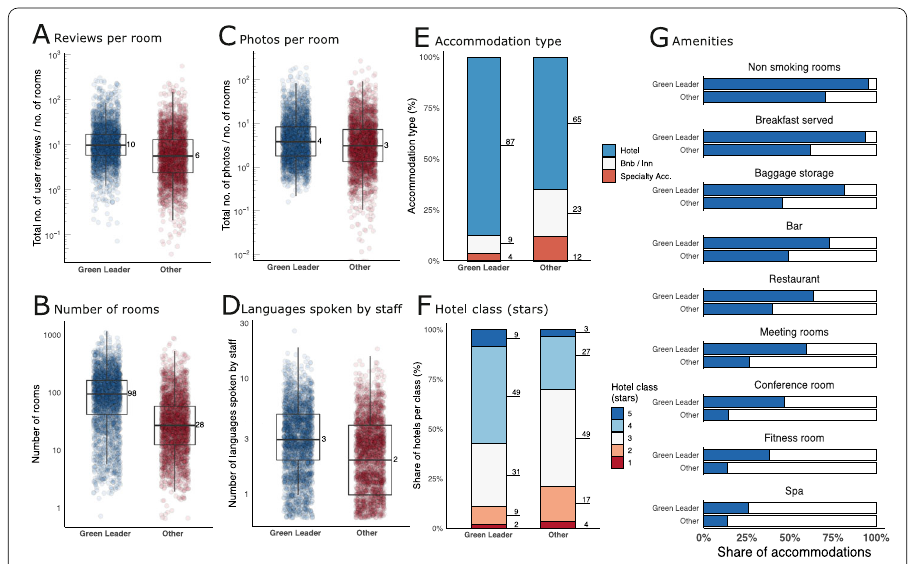
and languages spoken by staff in GreenLeader (blue) and other (red) accommodations. ( E )–( F ) Proportion of accommodation types and hotel class (stars) in the groups of GreenLeader (left) and other (right) accommodations. ( G ) Proportion of amenities in the groups of GreenLeader (top) and other (bottom) accommodations. GreenLeader accommodations tend to be larger, have more user interactions, are of